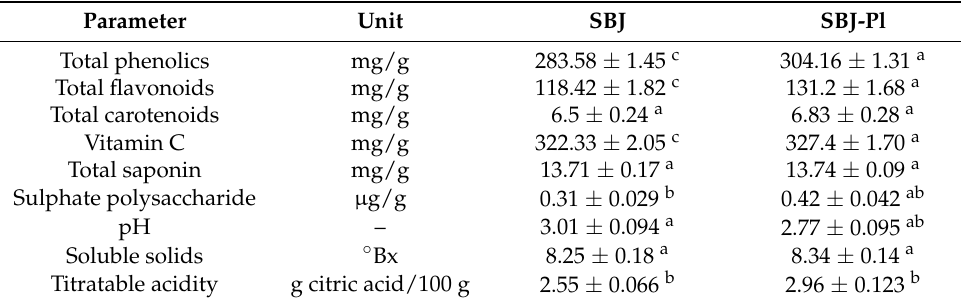
Table 3. Phytochemical and physical analysis of sea buckthorn juice